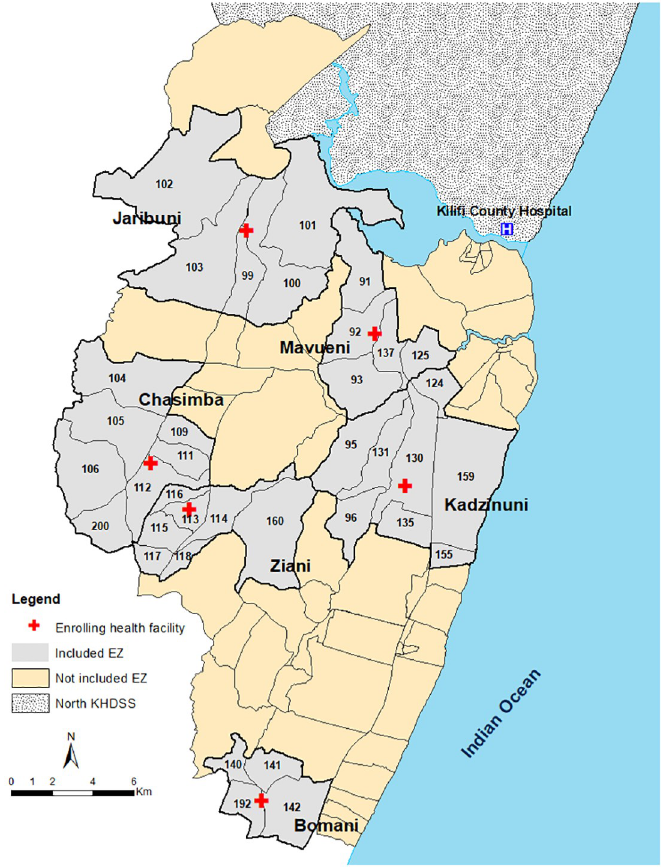
Fig 1. Map showing the location of the study sites and included enumeration zones